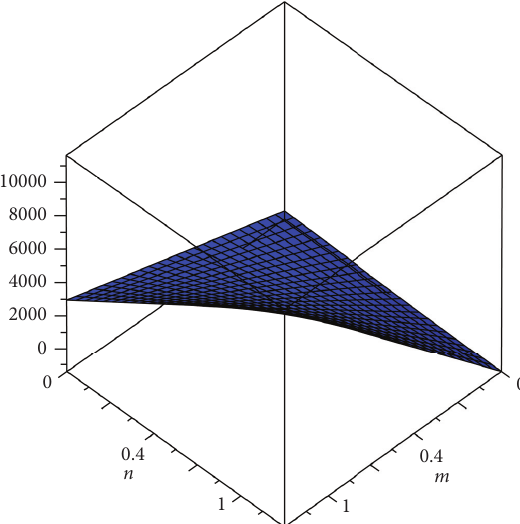
Figure 30: Plots of the first hyper-Gourava index for Bil